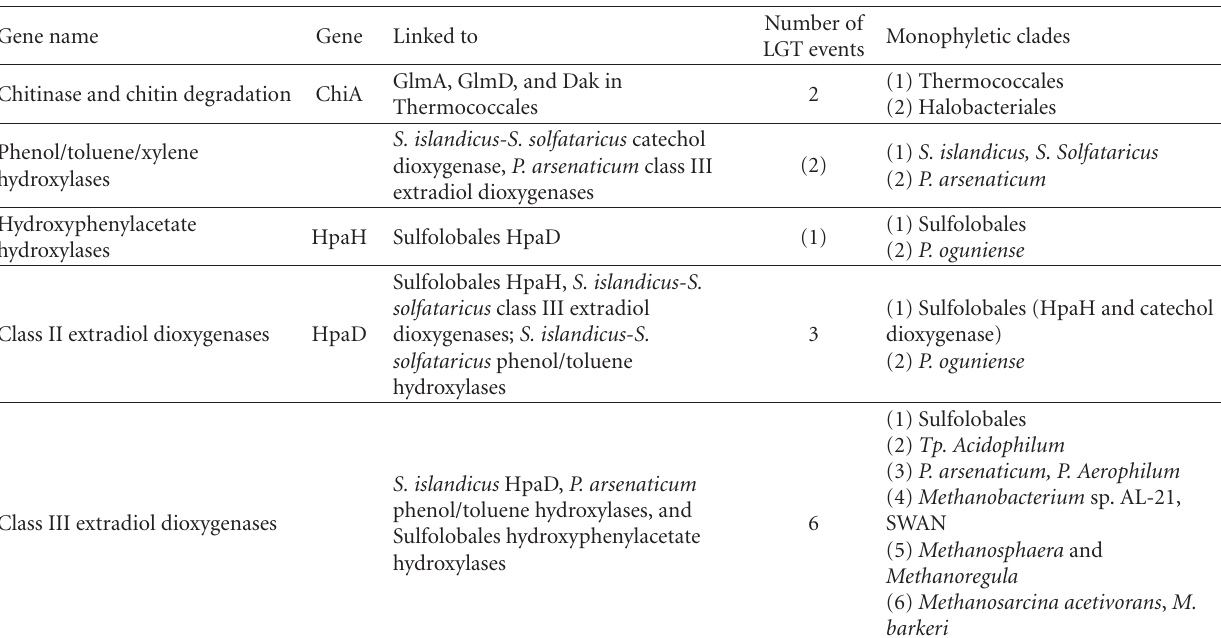
Figure 10: Nitrate reduction. Phylogenetic trees for nitrate reductase (a) catalytic alpha subunit (NarG) and (b) electron transfer beta subunit (NarH). Table 4: Organic carbon